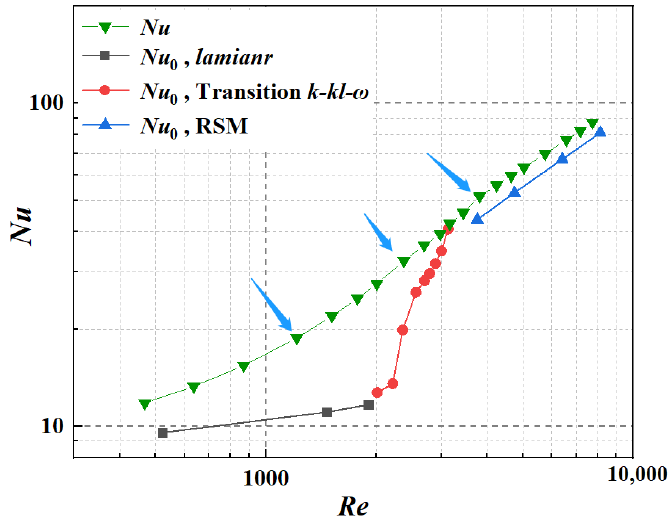
Figure 21. Variation in Nusselt number with Reynolds number.